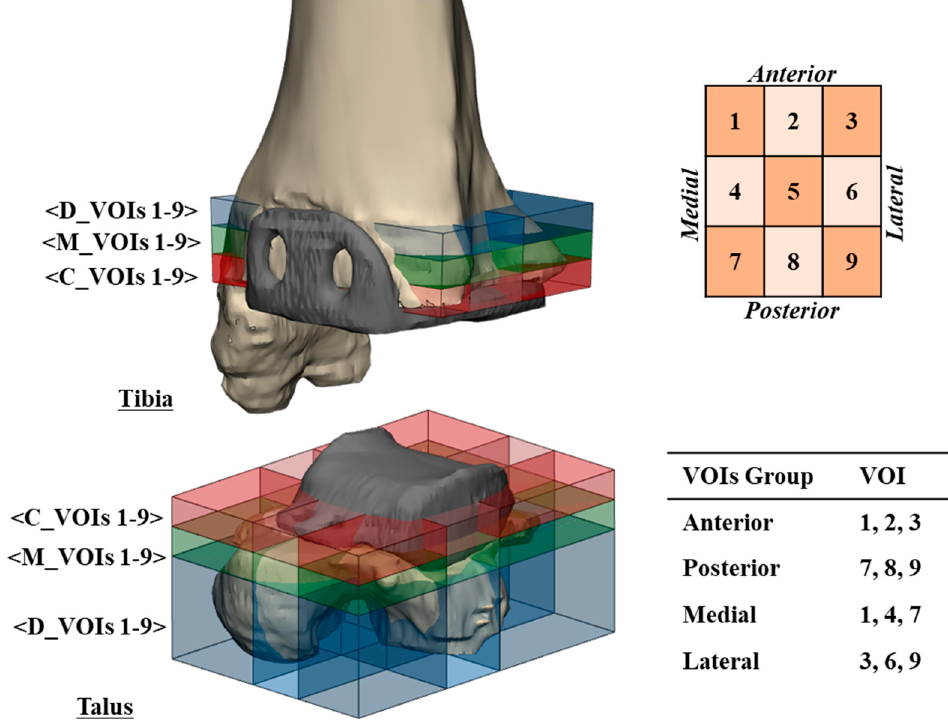
Figure 3. Volumes of interest (VOIs) defined in the distal tibia and the proximal talus for measures of location, distribution, and volume of osteolysis. Blue, green, and red represent VOIs in distant-peripheral (D_VOIs 1–9), mid-peripheral (M_VOIs 1–9), and closest peripheral (C_VOIs 1–9) regions, respectively.